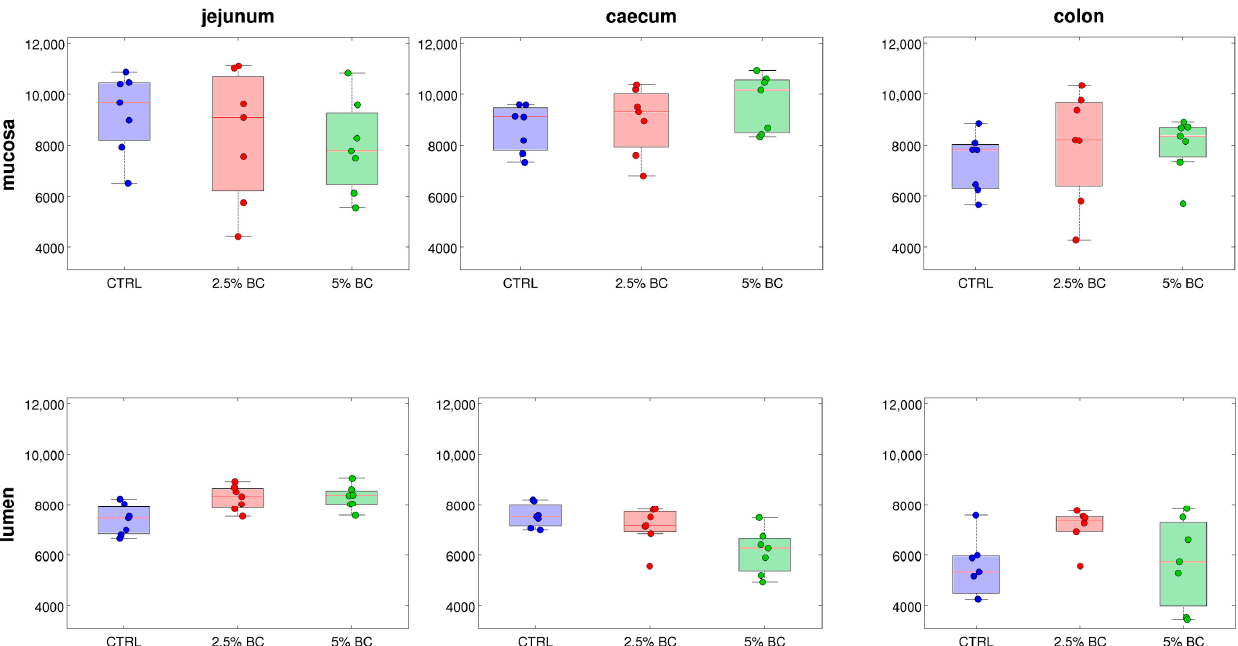
Figure 2. Boxplots describing the trends of chao1-based alpha-diversity for increasing % of colostrum in diets divided per intestinal tract and site. Each dot represents a sample, red lines are the median values of the distributions, the box indicates the 25% and 75% percentiles, and whiskers indicate the minimum/maximum values.